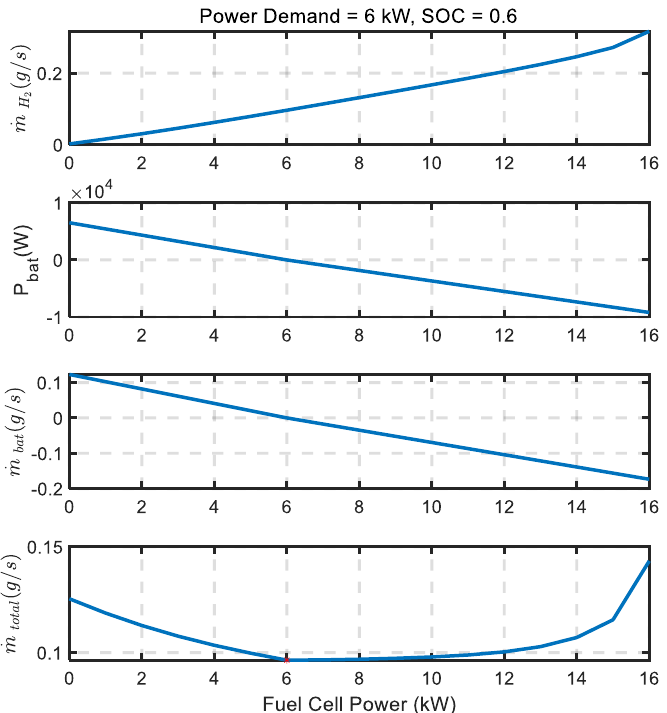
Figure 6. Illustration of the algorithm operation at power demand of 6 kW and 60% SOC.